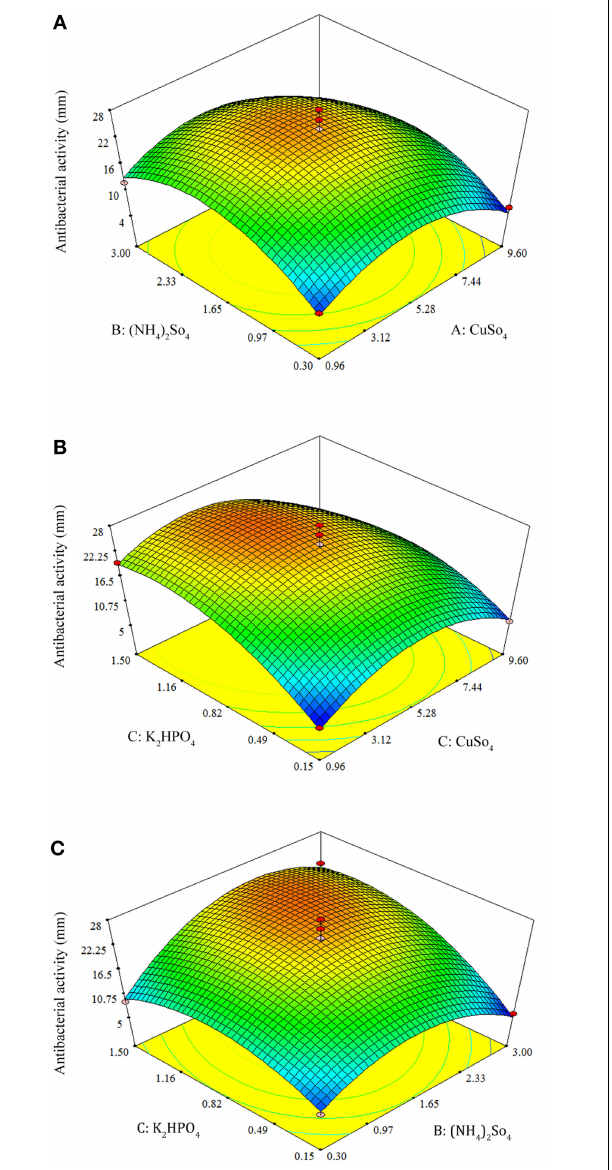
FIGURE 7 | Response surface 3D plots showing individual and interactive effects of variables on antibacterial activity of Streptomyces sp. JAJ13. (A) Effects of (NH 4 ) 2 SO 4 and CuSO 4 .5H 2 O on antibacterial activity. (B) Effects of K 2 HPO 4 and CuSO 4 .5H 2 O on antibacterial activity. (C) Effects of K 2 HPO 4 and (NH 4 ) 2 SO 4 on antibacterial